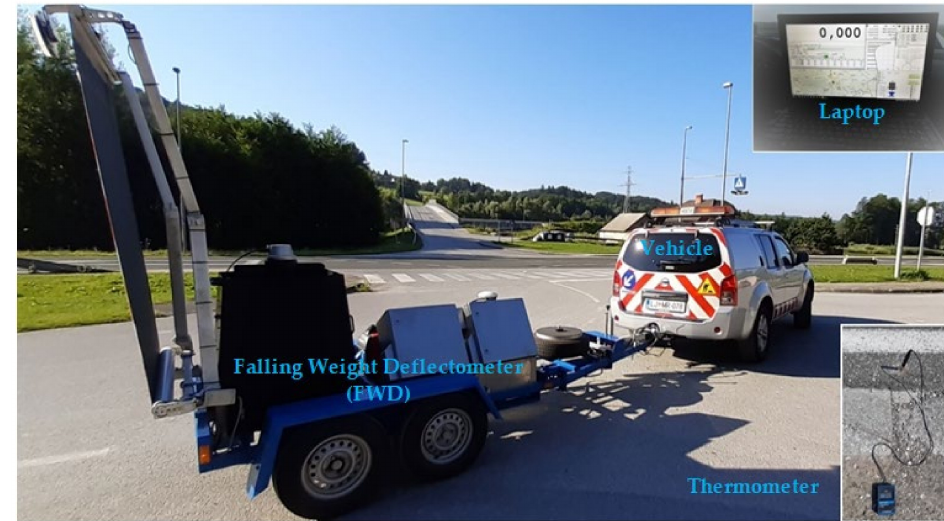
Figure 8. The used falling weight deflectometer (FWD) measurement equipment.